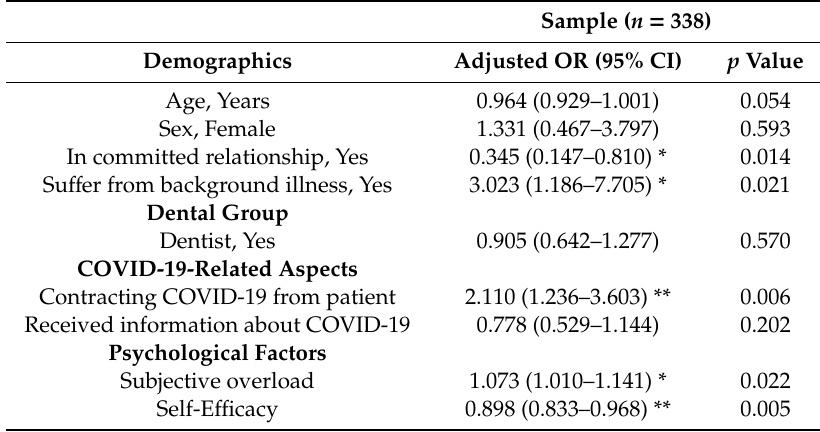
Table 1. Factors associated with psychological distress among dentists and dental